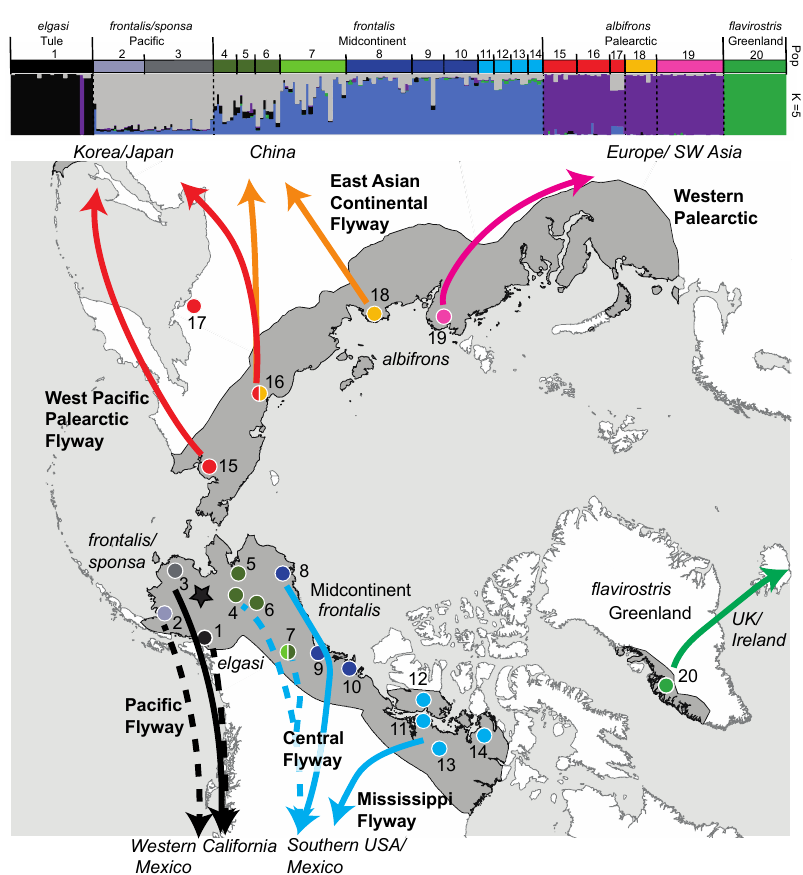
Figure 1. Population subdivision based on ADMIXTURE (top panel) with greater-white fronted goose ( Anser albifrons ) breeding distribution (dark gray) and subspecies designations in italic text (bottom panel). ADMIXTURE plot shows average assignment probability based on all biallelic SNPs in the ddRAD-seq dataset for K = 5 (see Supplemental Figure S3 for plots of other K values). Dashed lines separate management units, and numbers and colored blocks above graph correspond to map locations (see Table 1). Color blocks indicate additional subdivision inferred from the fineRADstructure analysis and colors correspond to circles in the bottom panel. Circles with two colors (7 and 16) designate areas where geese were assigned to two different genetic clusters (see Figure 3). General migratory direction is designated by arrows with dashed lines indicating populations with differential timing of migration within the same flyway. General wintering area for each migratory flyway is shown in italics. The black star indicates a shared molting site (Innoko, AK) used by both Pacific Flyway and Interior Alaska (dark green circles) populations, the latter migrating in the Central